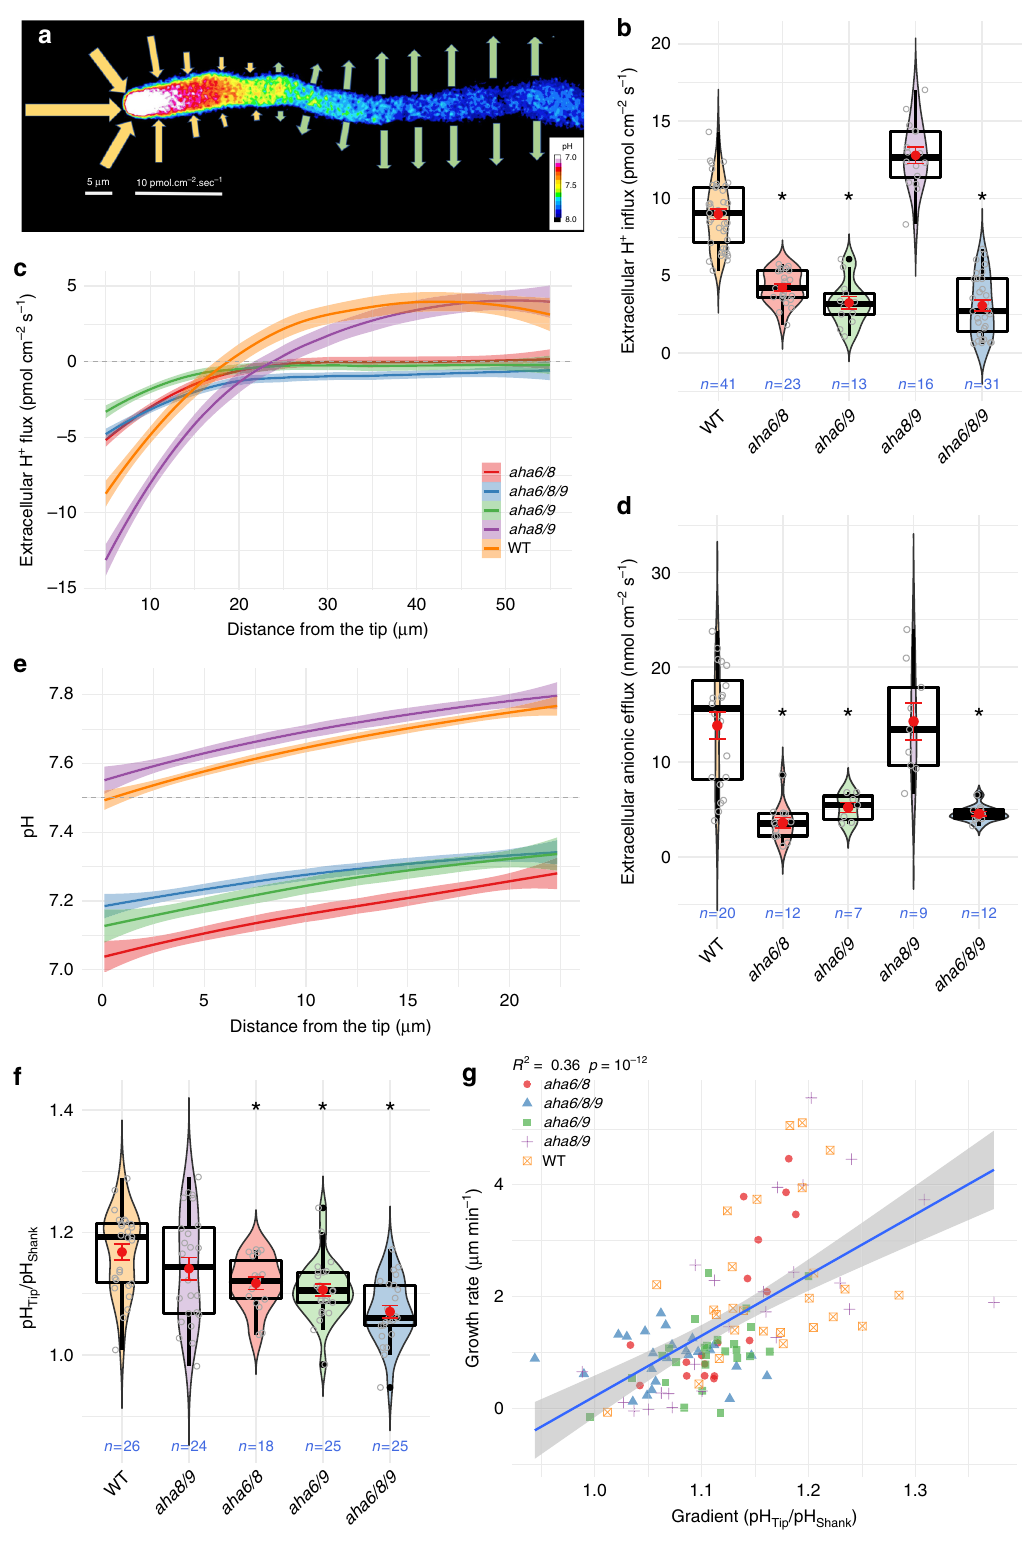
Mutant tubes have a lower frequency of H + oscillations . When cytosolic pH was quanti fi ed as a function of time using CHU- KNORRIS 37 , we observed pronounced pH oscillations in all genotypes (Fig. 4b, c, Supplementary Fig. 10). The aha6/8/9 triple mutant showed the largest difference from the wild-type, with an increased period of synchronized oscillations between